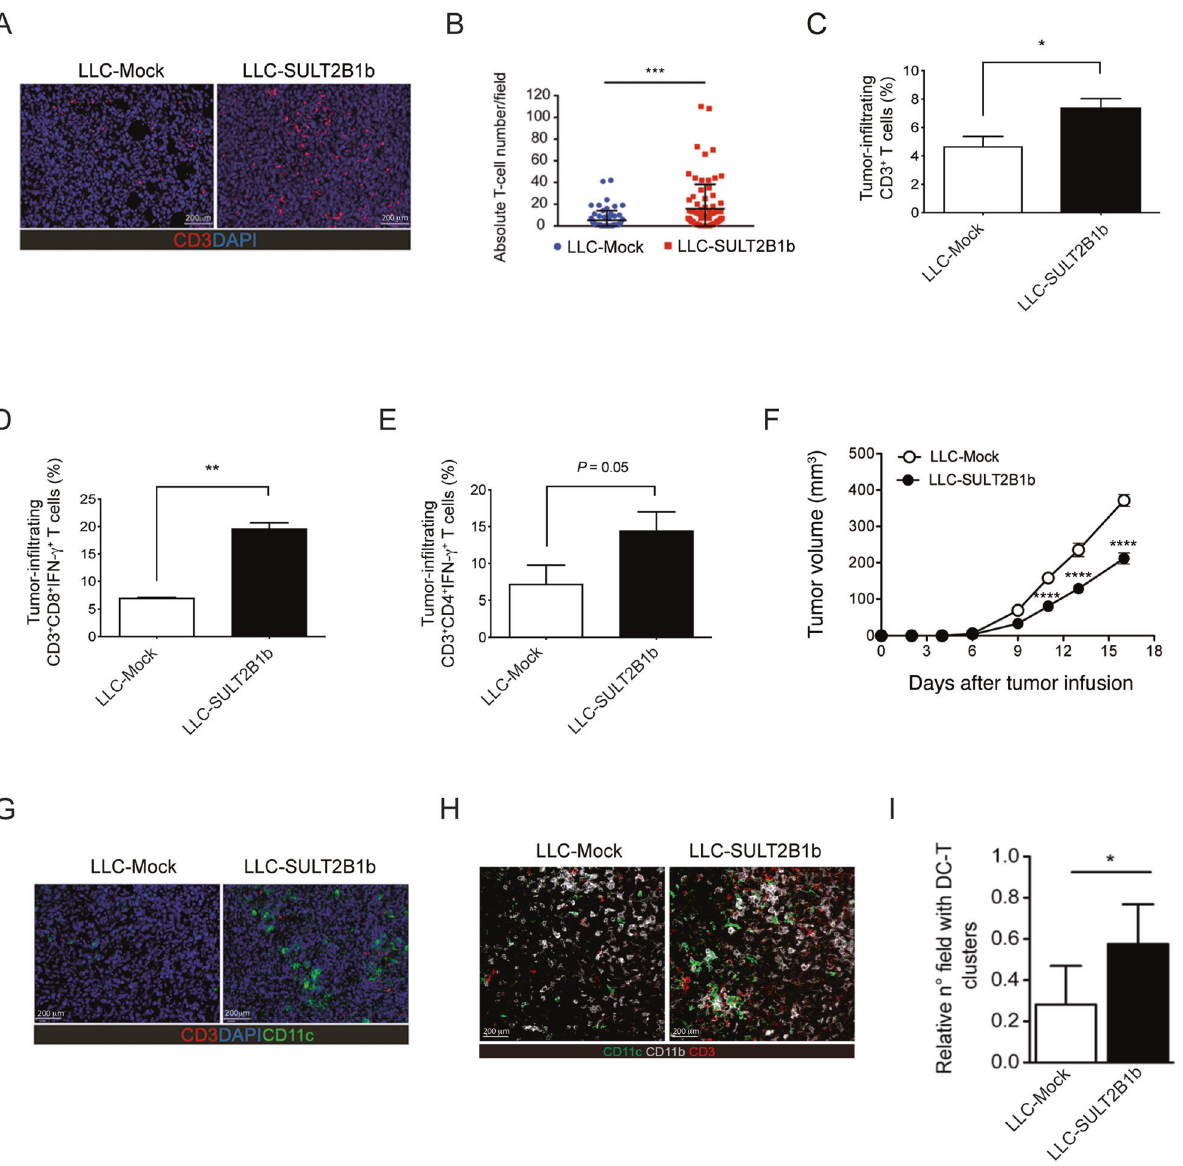
Fig. 1 Analysis of the LLC tumor microenvironment under SULT2B1b perturbation. A One representative confocal microscopy imaging of CD3 + T cells in fi ltrating LLC-Mock and LLC-SULT2B1b tumors. Red, CD3 + T cells; Blue, DAPI (bars = 200 µm). B Absolute T cell number/ fi eld evaluated by counting 4 different experiments with FIJI software (extension of ImageJ) and classical cell counter. DAPI + events (blue) displaying CD3 staining (red) were considered as positive T cells. *** P < 0.001 (Student ’ s t-test). C Flow cytometry analysis of the percentage of CD45 + CD3 + T cells in fi ltrating LLC-Mock and LLC-SULT2B1b tumors. * P < 0.05 (Student ’ s t-test). Mean and s.d. of four experiments. D Flow cytometry analysis of the percentage of CD3 + CD8 + INF- γ + T cells in fi ltrating LLC-Mock and LLC-SULT2B1b tumors. ** P < 0.01 (Student ’ s t-test). Mean and s.d. of two experiments. E Flow cytometry analysis of the percentage of CD3 + CD4 + INF- γ + T cells in fi ltrating LLC - Mock and LLC- SULT2B1b tumors. P = 0.01 (Student ’ s t-test). Mean and s.d. of two experiments. ( F ) LLC-Mock and LLC-SULT2B1b tumor growth. Mean and s.d. of one experiment ( n = 10 mice/group). **** P < 0.0001 (Student ’ s t-test). ( G and H ) Representative confocal microscopy imaging of CD3 + T cells and CD11c + cells ( G ) and CD3 + T cells, CD11b + and CD11c + cells ( H ) in fi ltrating LLC-Mock and LLC-SULT2B1b tumors. Red, CD3 + T cells; Blue, DAPI, Green, CD11c; Gray, CD11b (bars = 200 µm). ( I ) Quanti fi cation of the fi elds of DC/T cell clusters evaluated by counting 4 different experiments with FIJI software (extension of ImageJ) and classical cell counter. The number of sections in each image displaying the presence of both DCs (CD11c + CD11b + ) and T cells (CD3 + ) was considered as a positive DC/T cell cluster. * P < 0.05 (Student ’ s commonalities (Fig. 3B). Cluster 2 grouped our mono-DCs and and blood monocytes [23], skin-derived macrophages, cDCs and Ly6C low cells with Tip-DCs [25], both groups isolated from tumors. monocyte-DCs [29], and lung-derived cDC1, cDC2, inf-cDC2 and monocyte-derived APCs [24]. Ly6C high CD11c + MHC-II + mono-DCs, Cluster 0, cells isolated from lung independently of their state of activation [24]. Cluster 0 also encompassed DC and monocytes as well as Ly6C low cells isolated from SULT2B1b- and Mock-LLC isolated from lymph nodes. Cluster 1 grouped cells isolated from tumors resulted to be closer to the Tip-DCs (Fig. 3A). By UMAP skin independently of their state of activation [29], and Cluster 3 analyses we identi fi ed 4 clusters grouping cells isolated from monocytes isolated from blood or bone marrow [23]. These different organs or pathologic conditions sharing some program